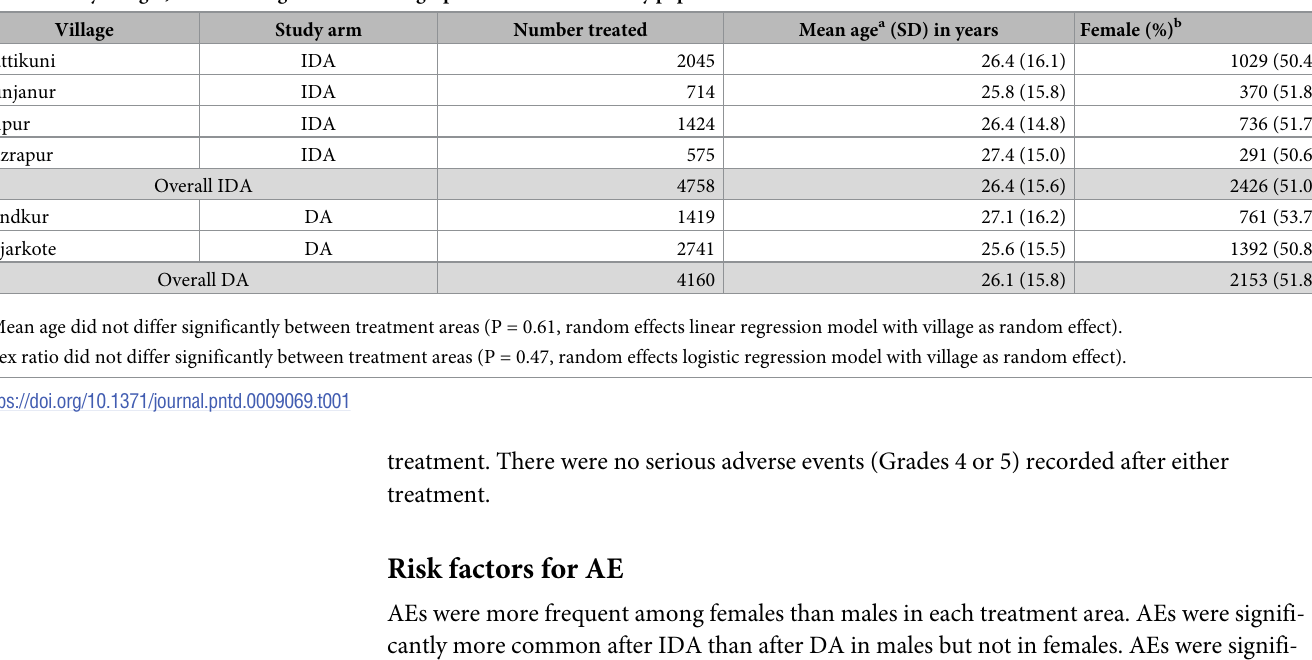
Table 1. Study villages, treatment regimen and demographic features of the study population.